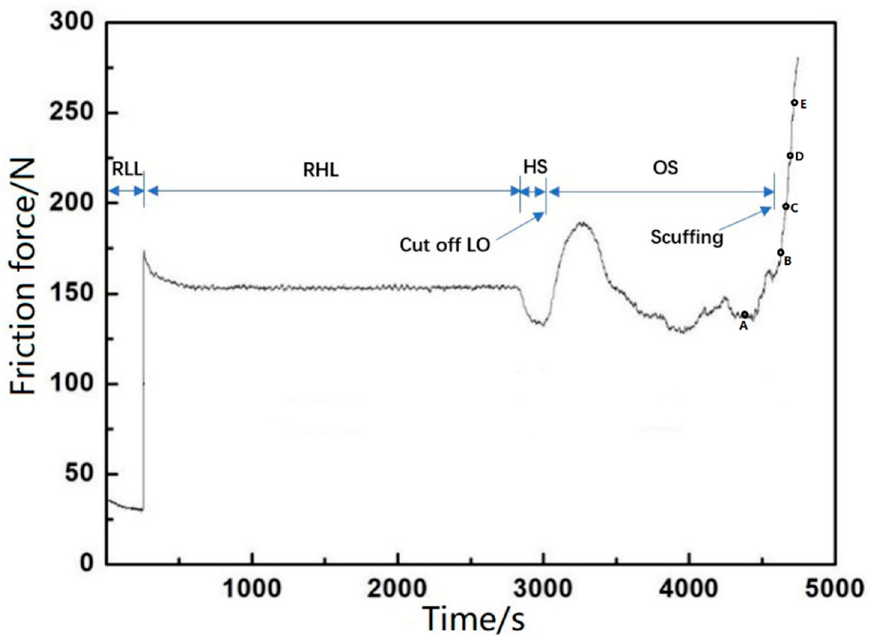
Figure 6. Typical maximum friction force variation in the running-in and starved lubrication experiment.